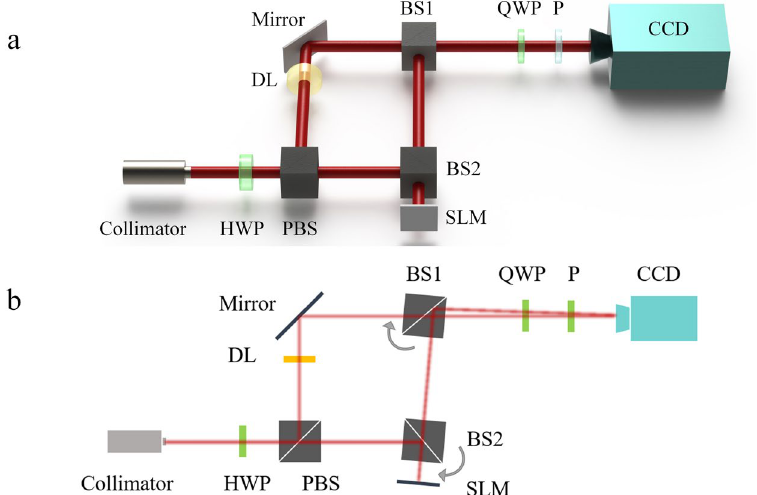
Figure 3. ( a ) The schematic of experimental arrangements. HWP: half-wave plate, PBS: polarizing beam splitter, BS: beam splitter, SLM: spatial light modulator, DL: delay line, QWP: quarter-wave plate, P: polarizer. ( b ) The tilt angle between the optical axis of the objective and reference light beam is controlled by rotating BS1, BS2 and